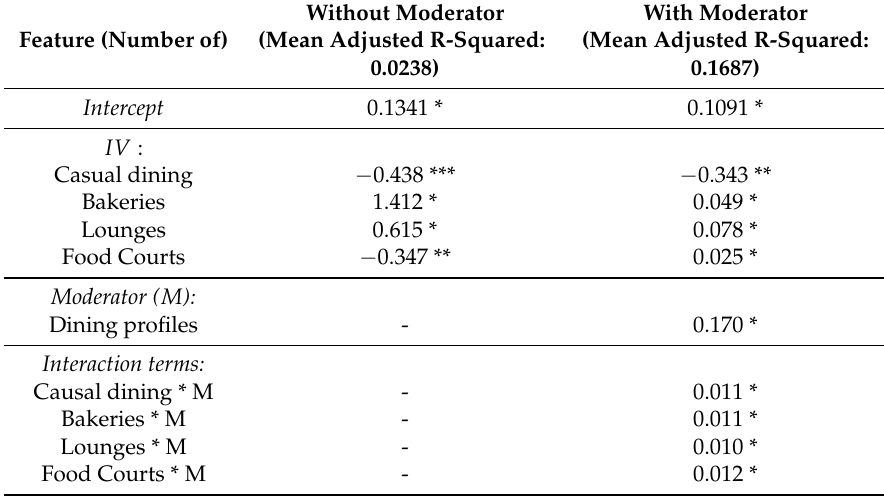
Table 4. Regression coefficients from Moderator analysis (interaction term = IV * M), Dining profiles